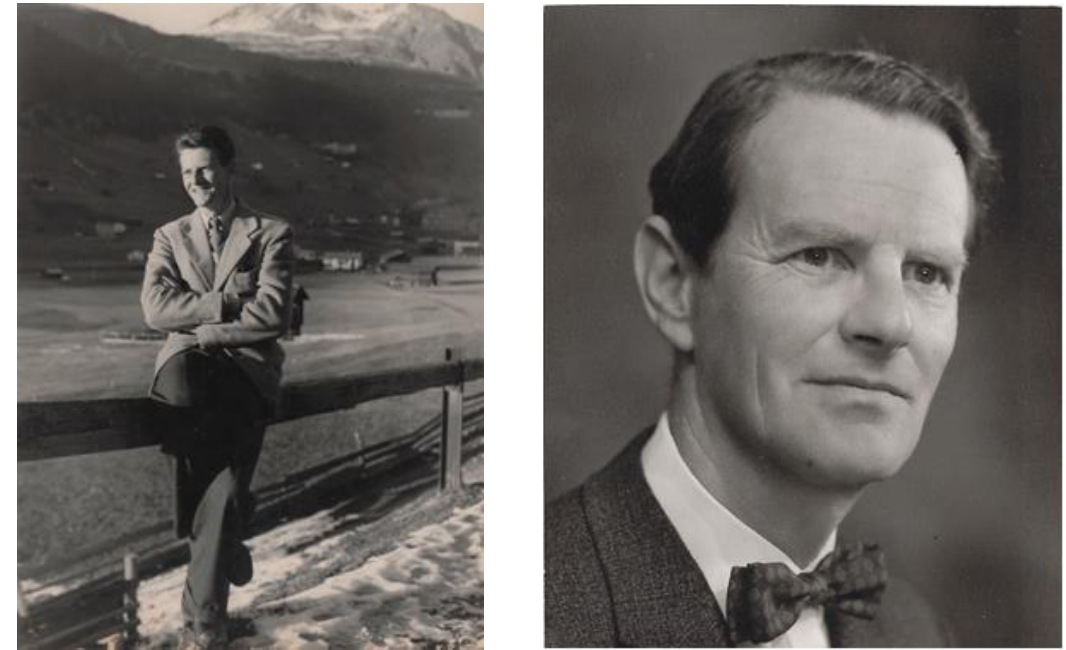
Figure 13. Max Wilson in Davos, Switzerland, circa 1946, left, and in the 1960s, right .